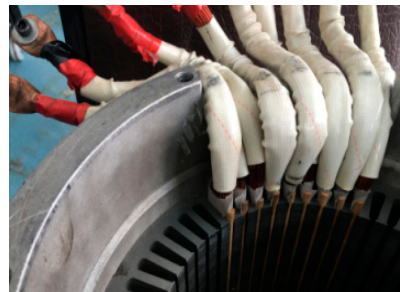
Figure 2. Multi-three-phase test prototype.